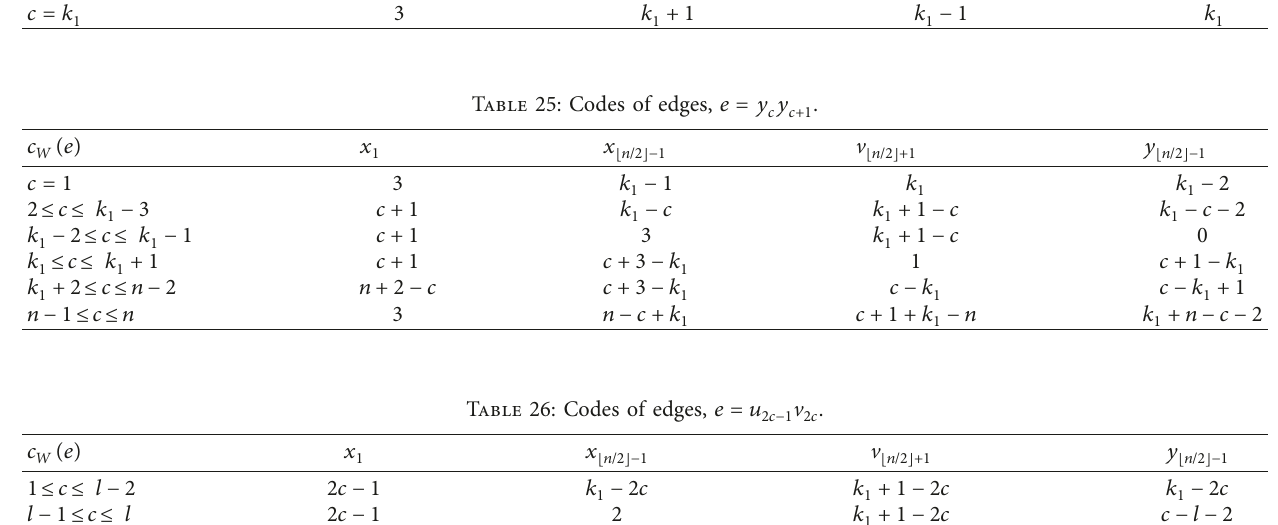
Table 24: Codes of edges, e � v